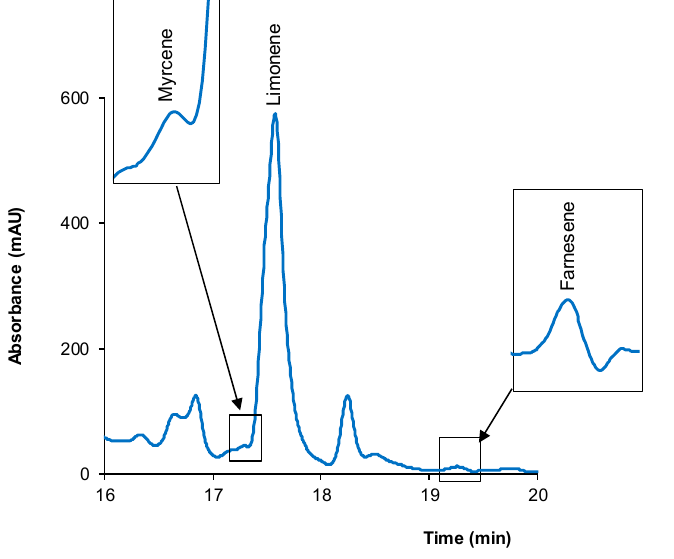
Figure 3. Peaks of limonene, myrcene, and farnesene in the chromatogram obtained for sample HP. For other experimental details, see text. Table 4. Results obtained for the dietary supplements analyzed (n = 3).